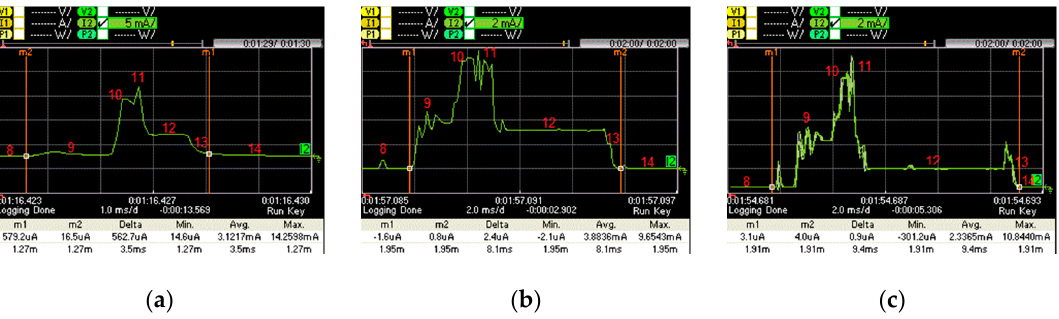
Figure 12. Current consumption of the active part of a connection interval with data packet transmission: ( a ) PCA10028; ( b ) LaunchPad; ( c ) SensorTag. Table 2. State characterization of a connection interval with data packet transmission.